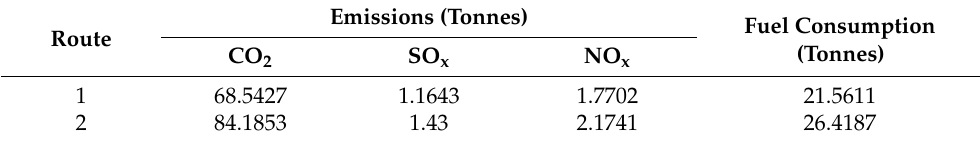
Table 9. Emission and fuel consumption.